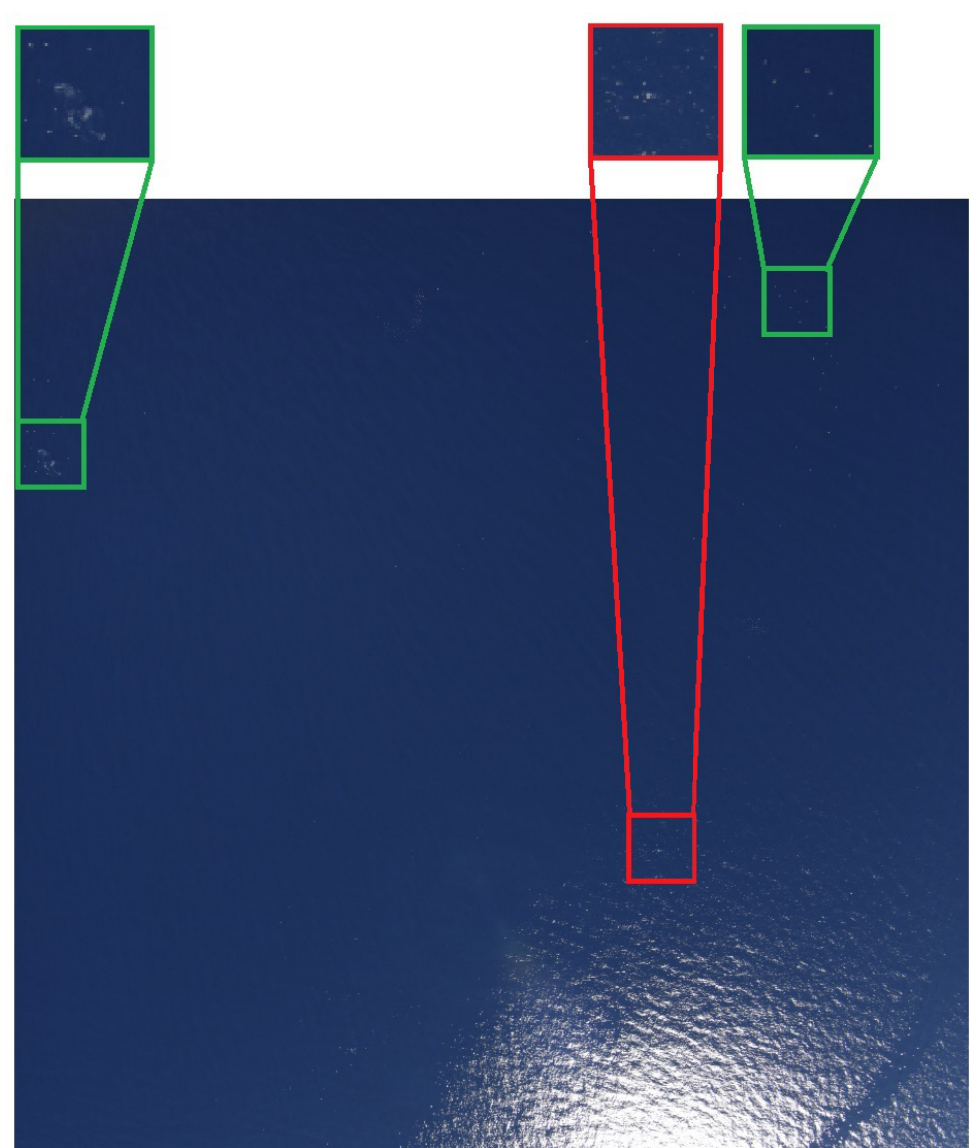
Figure 3. Image captured during an Ifremer flight session. The bright dots inside the green boxes may correspond to marine animals while that the ones inside the red box might be sun